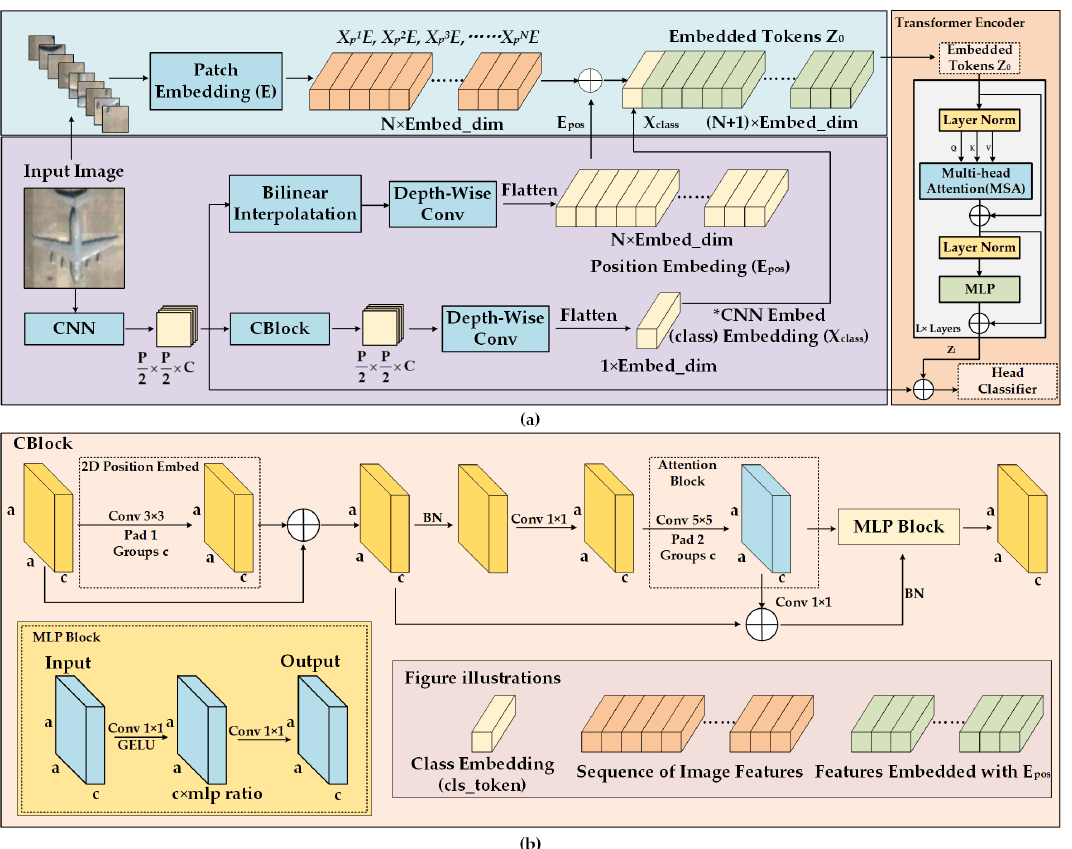
Figure 5. The network architecture of the proposed P 2 FEViT. ( a ) refers to the overall architecture of our method, and ( b ) refers to the detailed structure of the